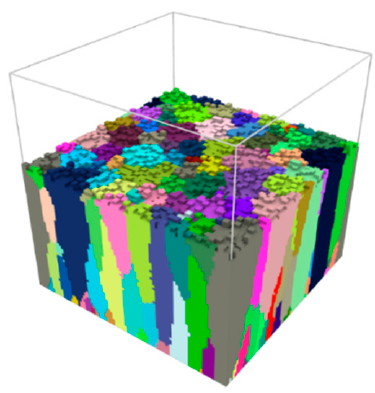
Substrate temperature 200 ◦ C Binding energy 0.8 eV Deposition rate 0.05 nm/s Vibration frequency 1 × 10 13 Hz The TiN thin film with the dimension of 90 nm × 90 nm × 90 nm was obtained from the kMC simulation. Example of the DMR model of thin film during kMC simulation is shown in Figure 5.